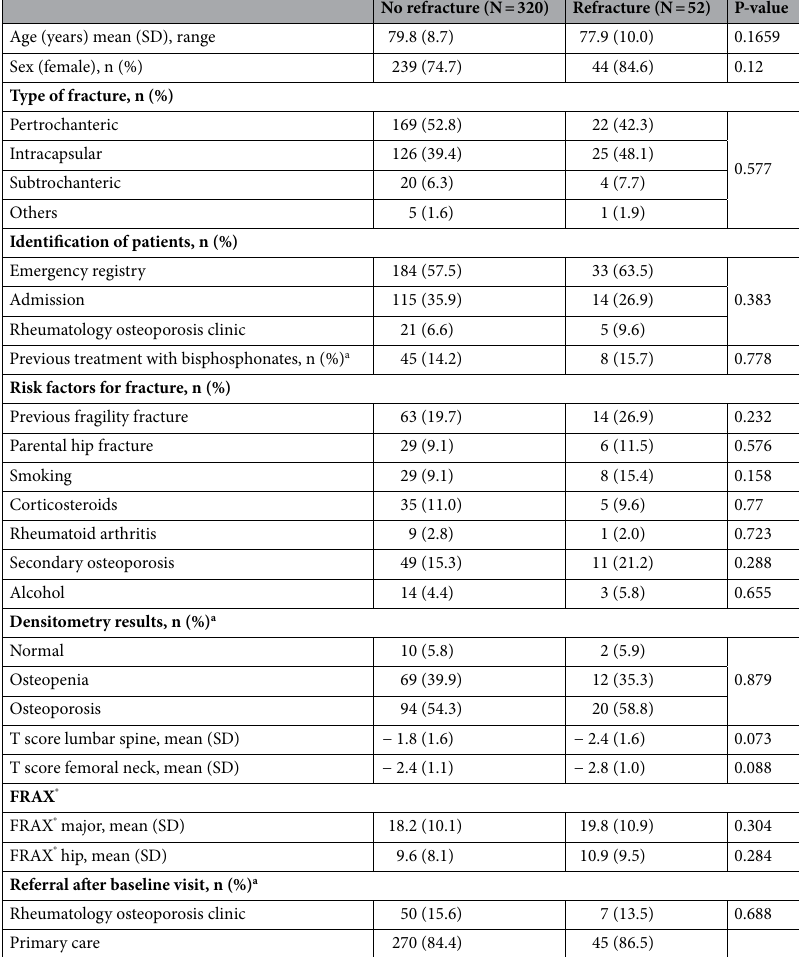
Table 4. Comparison of baseline characteristics of patients with and without refracture during follow-up. a Previous treatment recorded in 369 patients. Densitometry values were recorded in 207 patients.